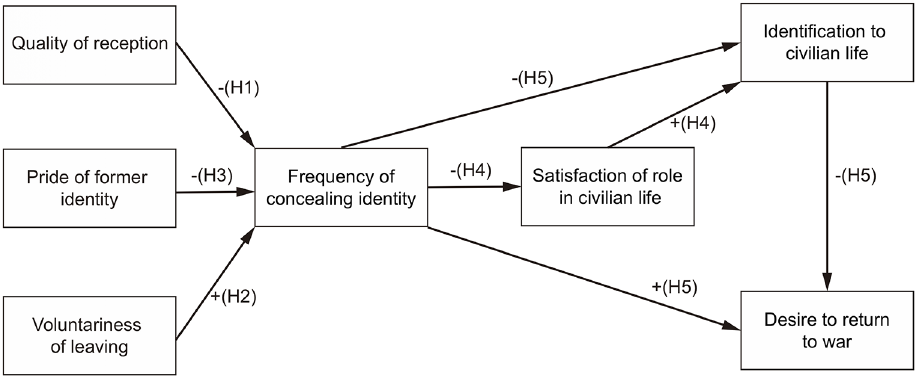
Figure 1. Theoretical